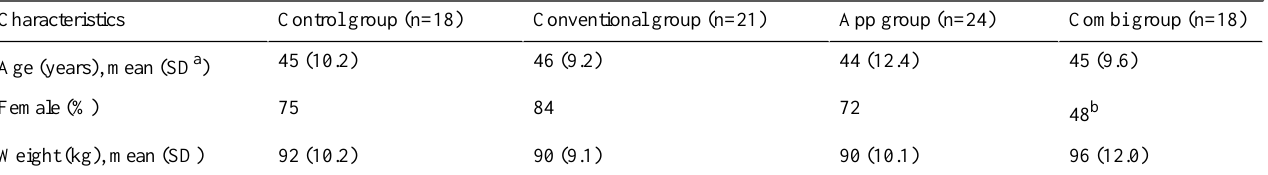
Table 1. Baseline characteristics of the participating